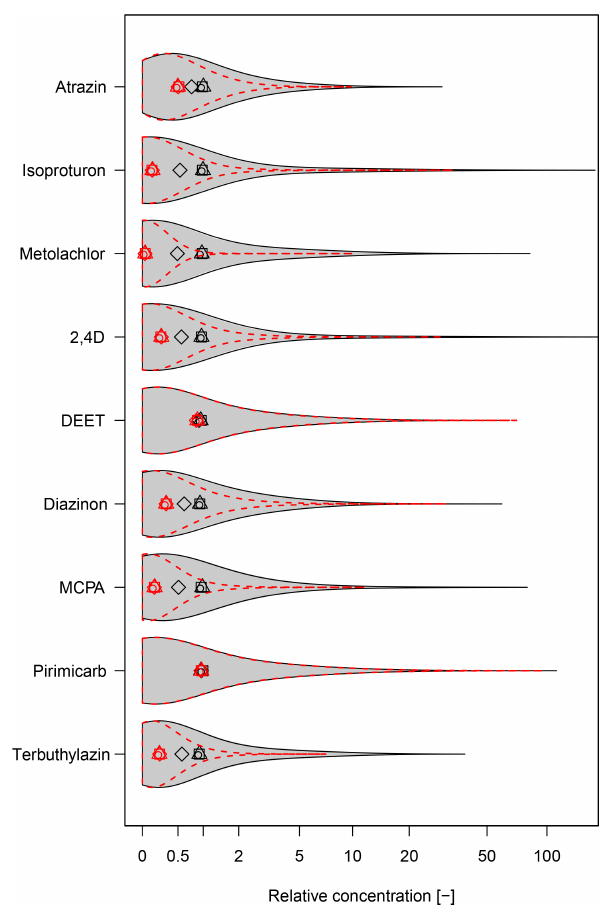
Figure 6. Ensemble future predictions for PPPs under management alternatives “all” (red) and “CurrPrac” (black), compared to present (grey). Distributions were normalized to be comparable across vari- ables. Open symbols indicate mean concentrations of individual scenarios: circle: “status quo”; square: “moderate growth”; dia- mond: “exploding growth”; pyramid: “decline”.